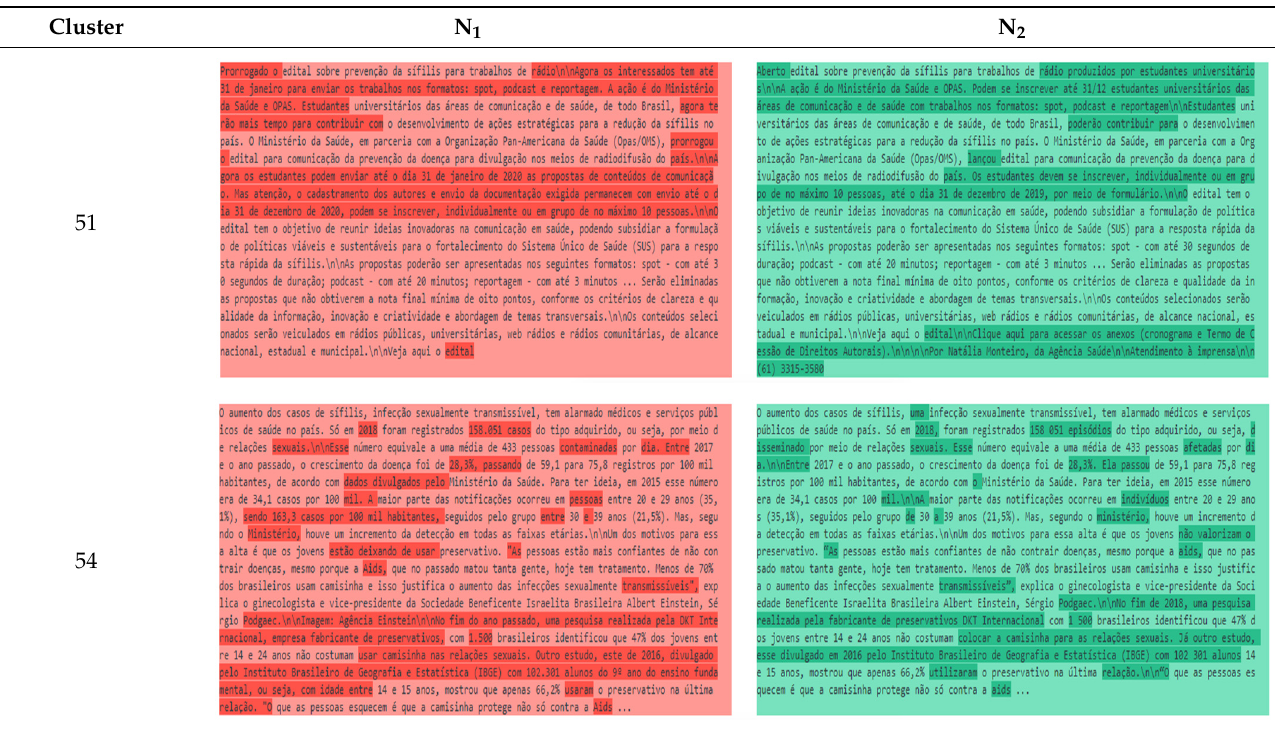
Table A1. Visualization and analysis of the news items.